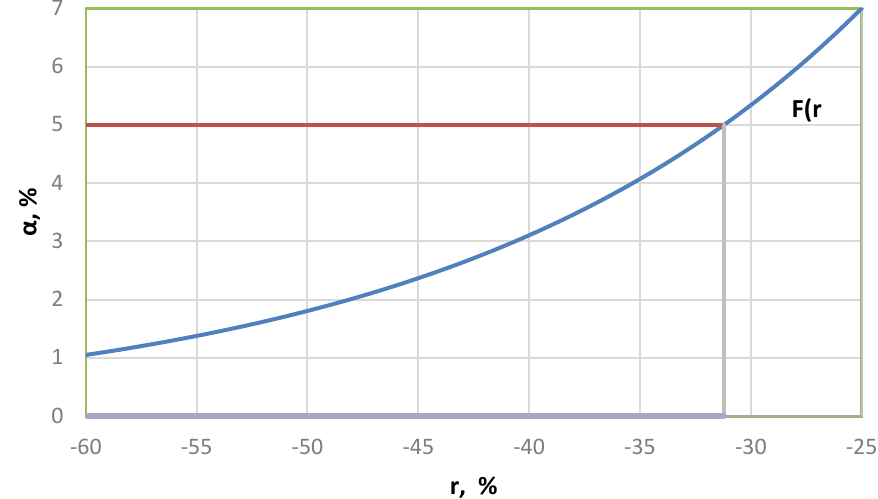
α = 5% (Wheat) Fig. 4: Determination of bound for risk zone VaR α at level Fig. 4: Determination of bound for risk zone VaR α at level α = 5% (Wheat) Table 3: Estimation of economic risk by quantile zones method ( α = 0.05) Table 3: Estimation of economic risk by quantile zones method ( α =